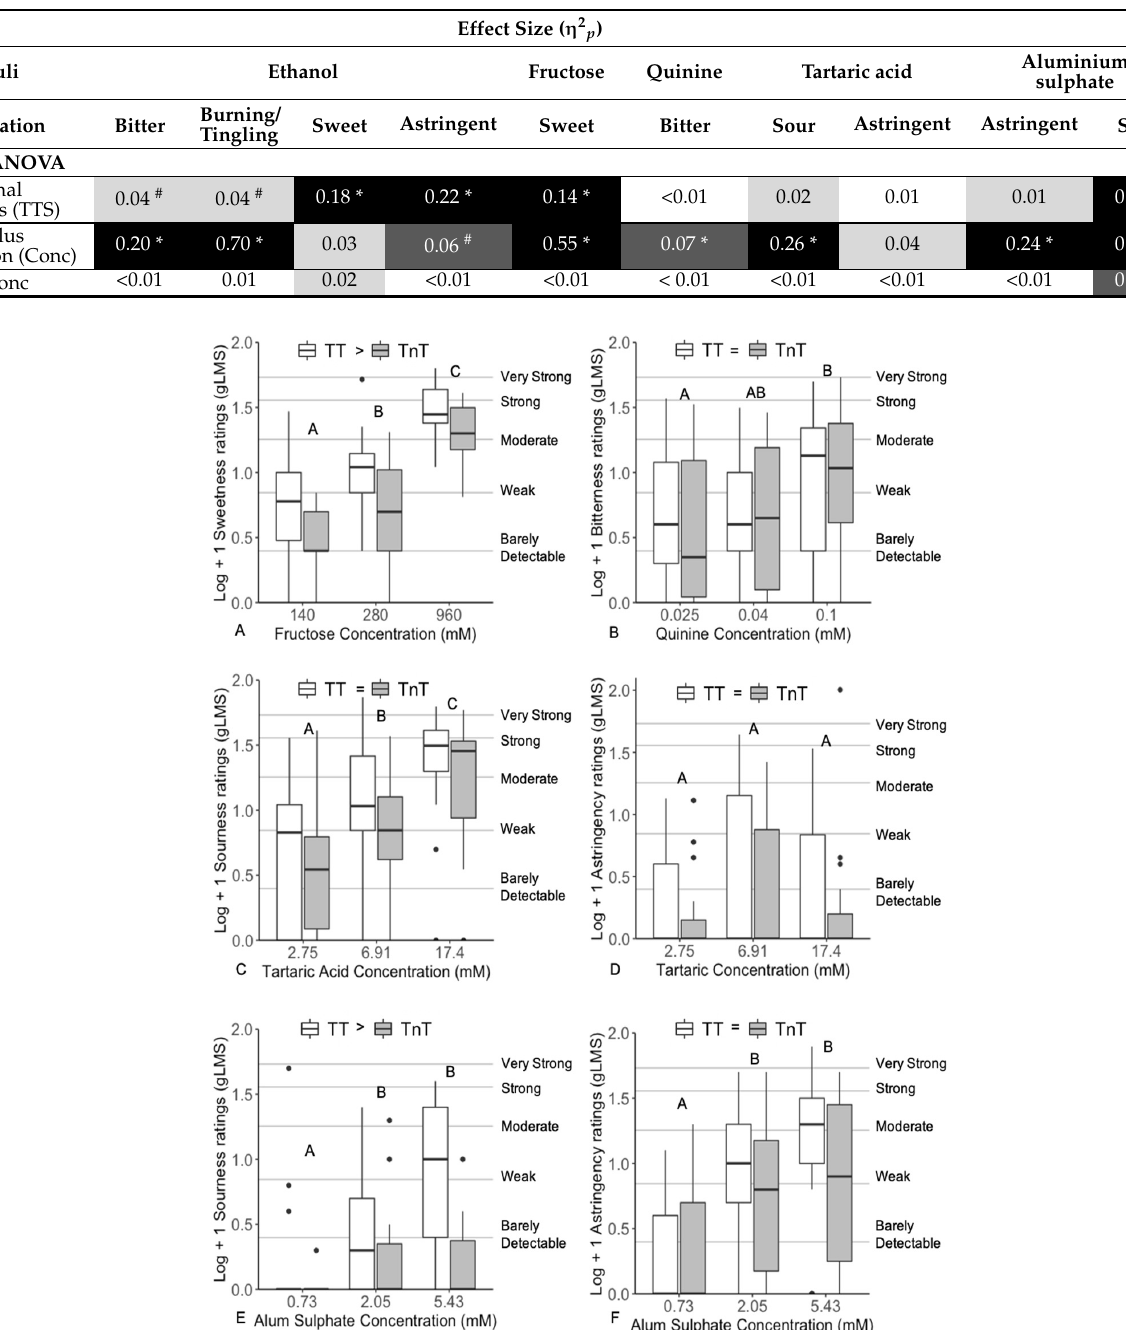
Table 2. Summary of effect sizes for two-way ANOVAs comparing intensity ratings by thermal taste status (TT and TnT) and stimuli concentration (low, medium, high) to orosensations elicited by unary solutions of ethanol, fructose, quinine, tartaric acid and aluminium sulphate. Note: The effect size is considered small, medium, or large, when η 2 p values exceed 0.01 (light grey), 0.06 (dark grey), or 0.140 (black), respectively [58]. Levels of significance in the corresponding ANOVAs are denoted by “*” and “ # ”, when P < 0.05 or P < 0.10, respectively.